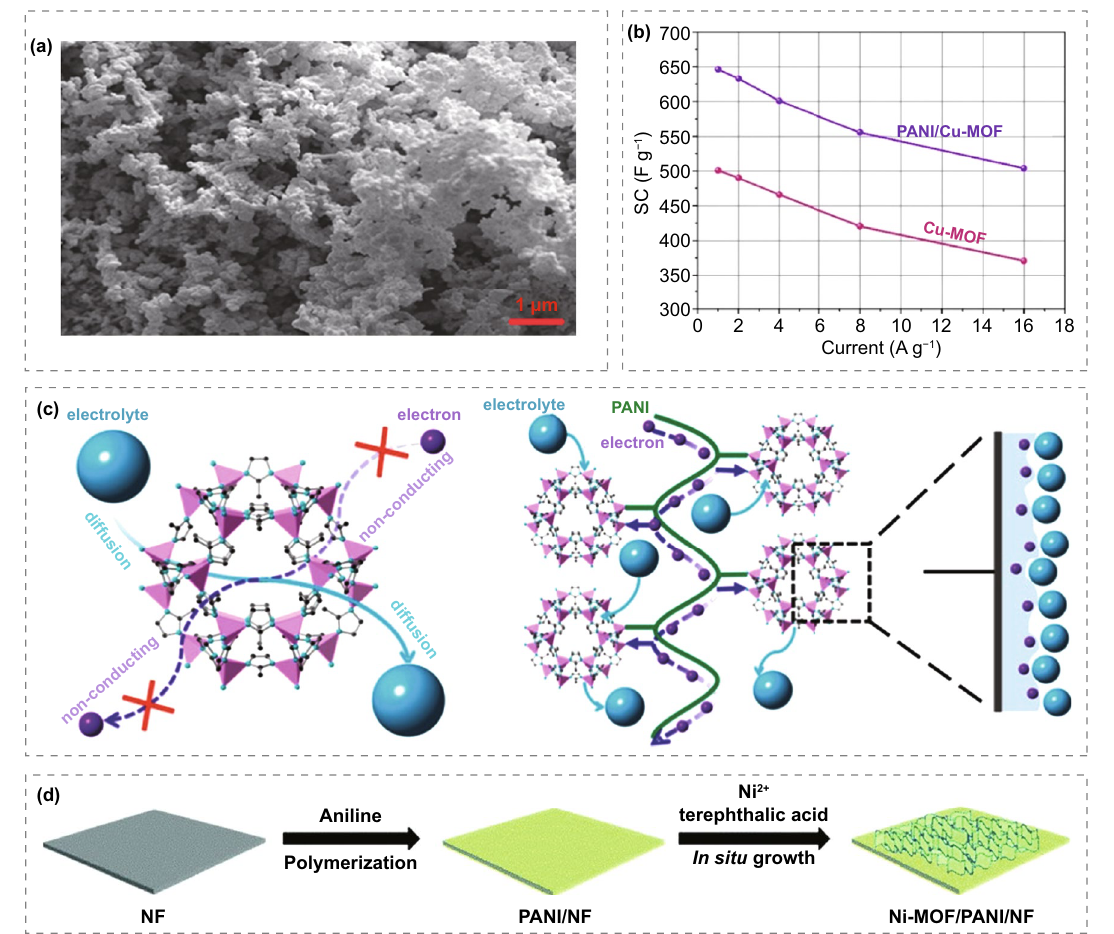
Fig. 8 a SEM of PANI/Cu-MOF nanocomposite. b Specific capacitance of Cu-MOF and PANI/Cu-MOF. Reprinted with permission from Ref. [118]. Copyright 2019 Springer Science Business Media. c Schematic diagram of electron conduction in MOF and MOF interweaves. Reprinted with permission from Ref. [119]. Copyright 2015 American Chemical Society. d Schematic diagram of Ni-MOF/PANI/NF synthesis. Reprinted with permission from Ref. [121]. Copyright 2019 Royal Society of